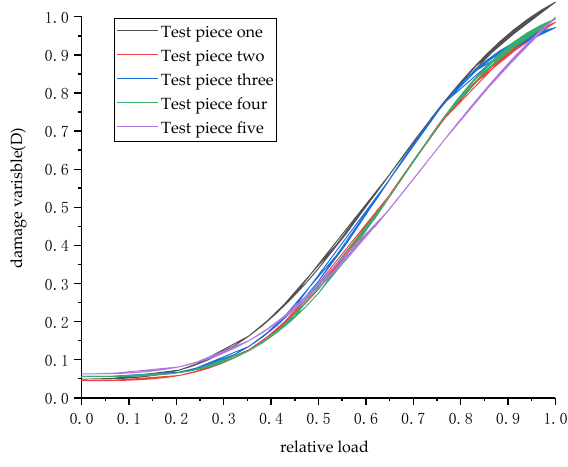
Figure 12. Damage evolution curve.